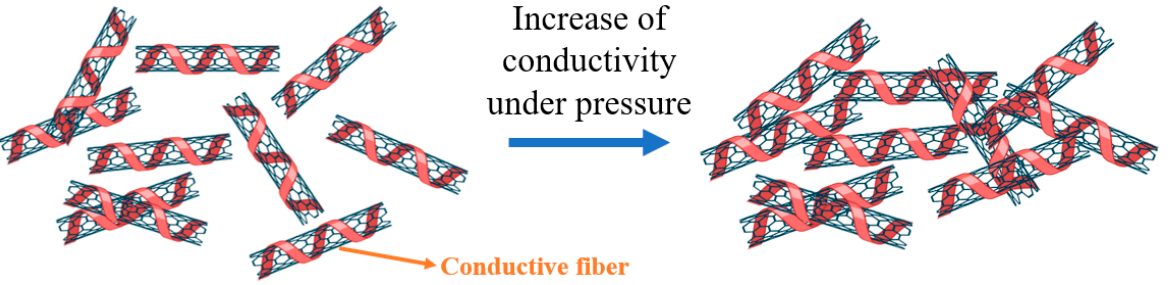
Figure 6. Schematic illustration of the conductive mechanism.